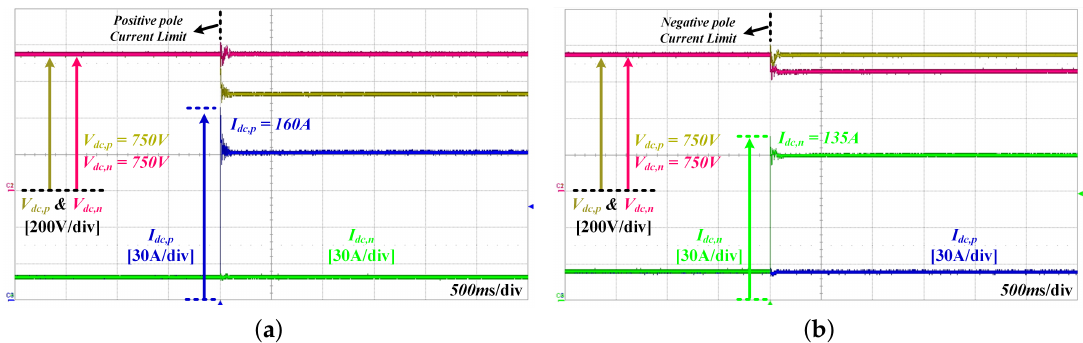
Figure 18. Experimental results of current limit operation in short-circuit condition: ( a ) Positive pole; ( b ) Negative